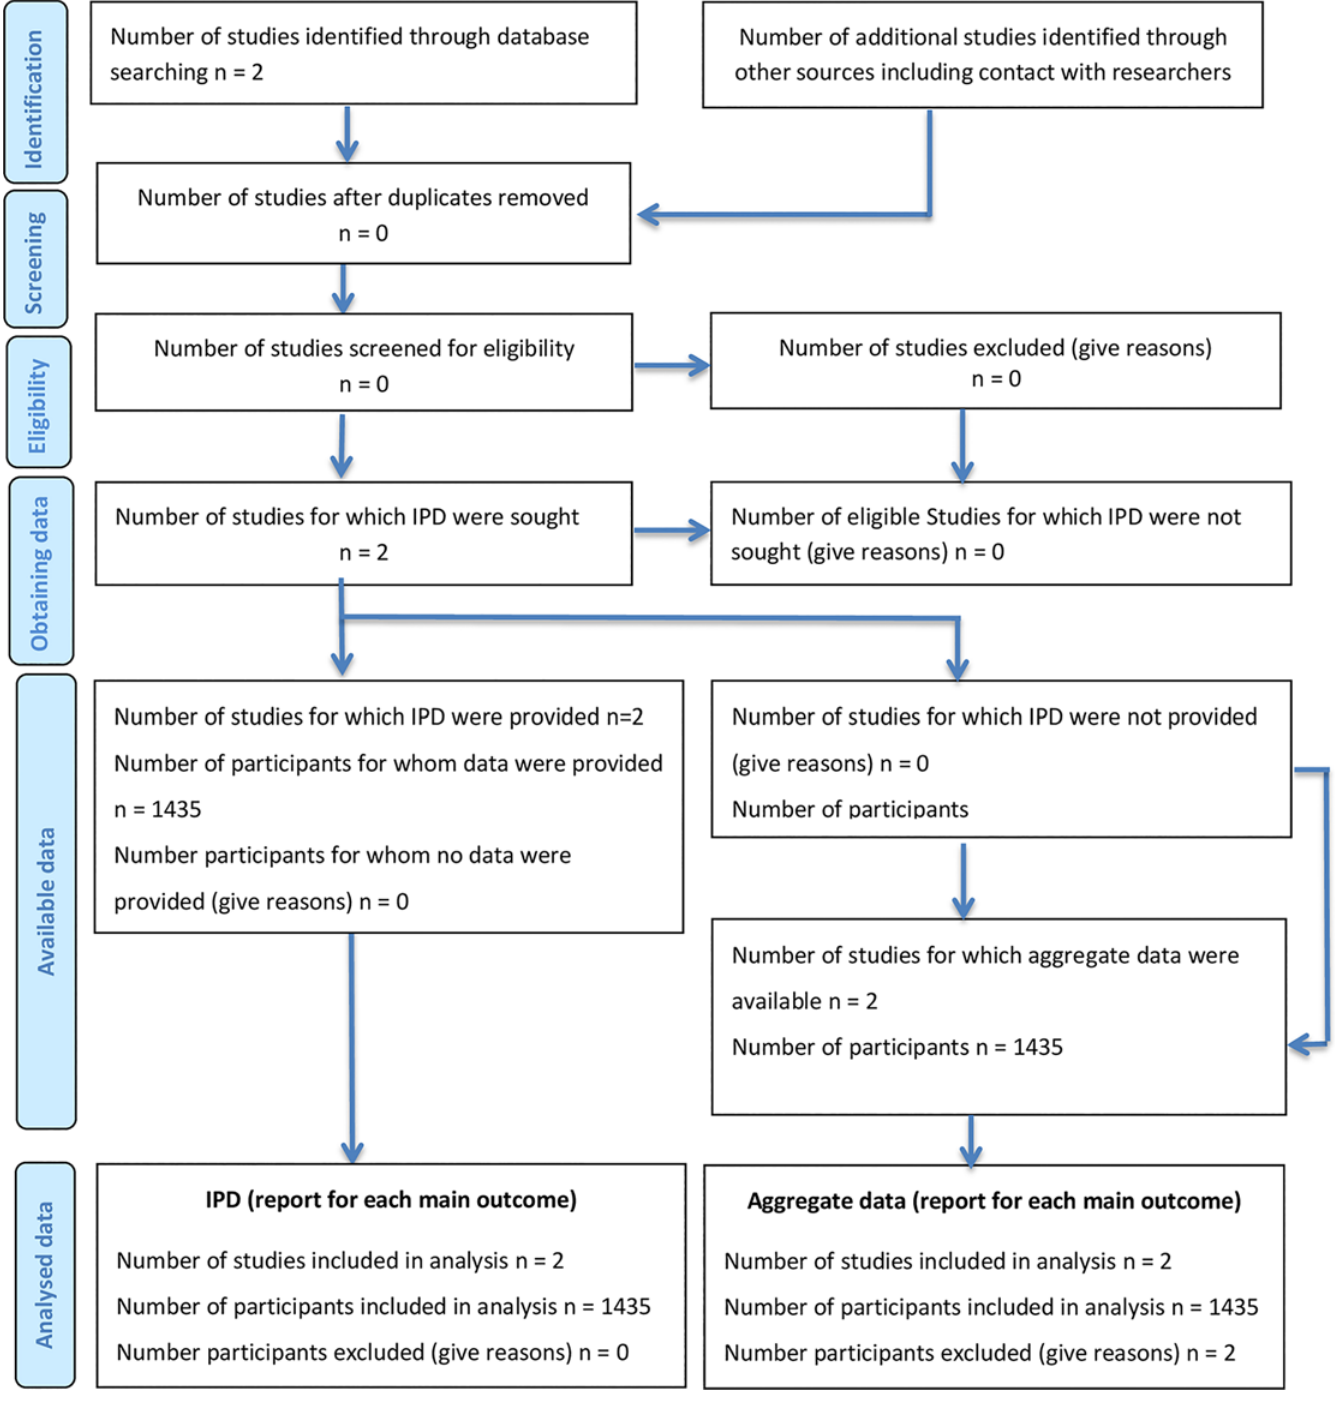
Fig 1. Flow Diagram of literature search and study inclusion according to PRISM guidelines for individual patient data meta-analyses.